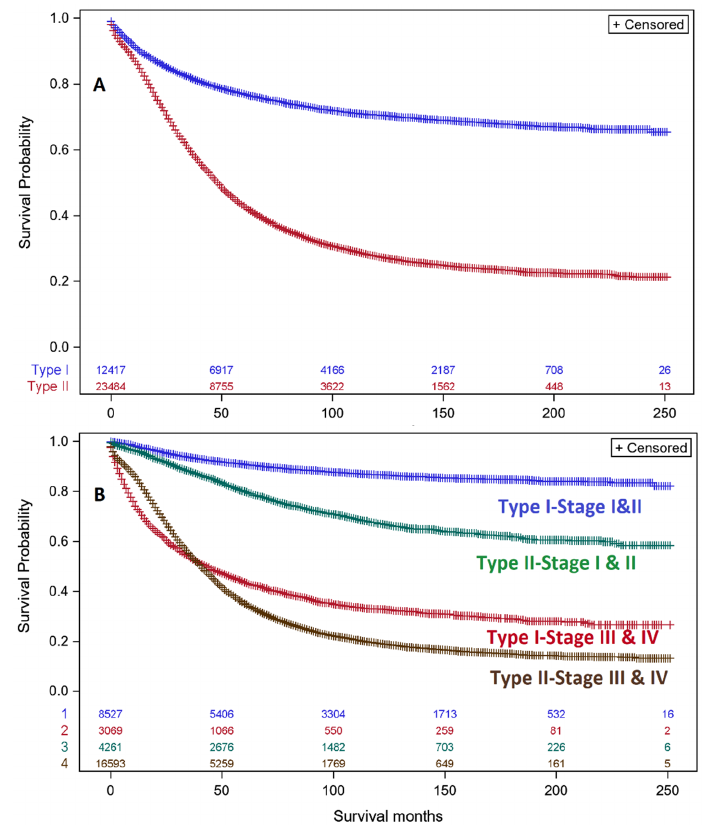
Figure 4. Kaplan–Meier survival of women with Type I & II EOC. ( A ). DSS of women with Type I EOC (blue curve, n = 12,417; 50, 100 & 200-month survival is 78.5%, 71.7%, 66.6%). DSS of women with Type II EOC (red curve, n = 23,484; 50, 100, & 200-month survival is 50.6%, 31.7%, 22.9%). p -value obtained by the log rank test. The number of women remaining at different survival points is shown for Type I (blue) and Type II (red) epithelial ovarian cancers. (Type I vs. Type II: p < 0.001). The number of women remaining at different survival points is color-coded for each of the four categories along the x -axis. Vertical lines identify censored data points. ( B ). DSS of women with Type I & II EOC according to stage. Early stage (I & II) Type I EOC (blue curve, n = 8,527; 50, 100 & 200-month survival is 91.9%, 87.7%, 84.9%). Early stage (I & II) Type II EOC (green curve, n = 4,261; 50, 100 & 200-month survival is 83.9%, 71.0%, 60.3%). Late stage (III & IV) Type I EOC (red curve, n = 3,069; 50, 100 & 200- month survival is 47.9%, 35.3%, 28.1%). Late stage (III & IV) Type II EOC (brown curve, n = 16,593; 50, 100 & 200-month survival is 44.2%, 23.4%, 15.2%) (Type I vs. Type II: p < 0.001). p -value obtained by the log rank test. The number of women remaining at different survival points is color-coded for each of the four categories along the x -axis. Vertical lines identify censored data points. 4. Discussion The important finding presented here is that the mortality of Type I late stage (III & IV) EOC is significant enough to challenge considering it as indolent. In addition, Type II early stage (I & II) EOC showed high DSS at 200 months (60.3%), indicating that when the extent of disease is limited the opportunity to overwhelm the body or “aggressiveness” is moderated. The work presented here is in agreement with recent reports on overall survival of EOC histo-types by Peres et al [27] and Lan & Yang [28]. The details of this agreement and comparisons to the work presented here are included in